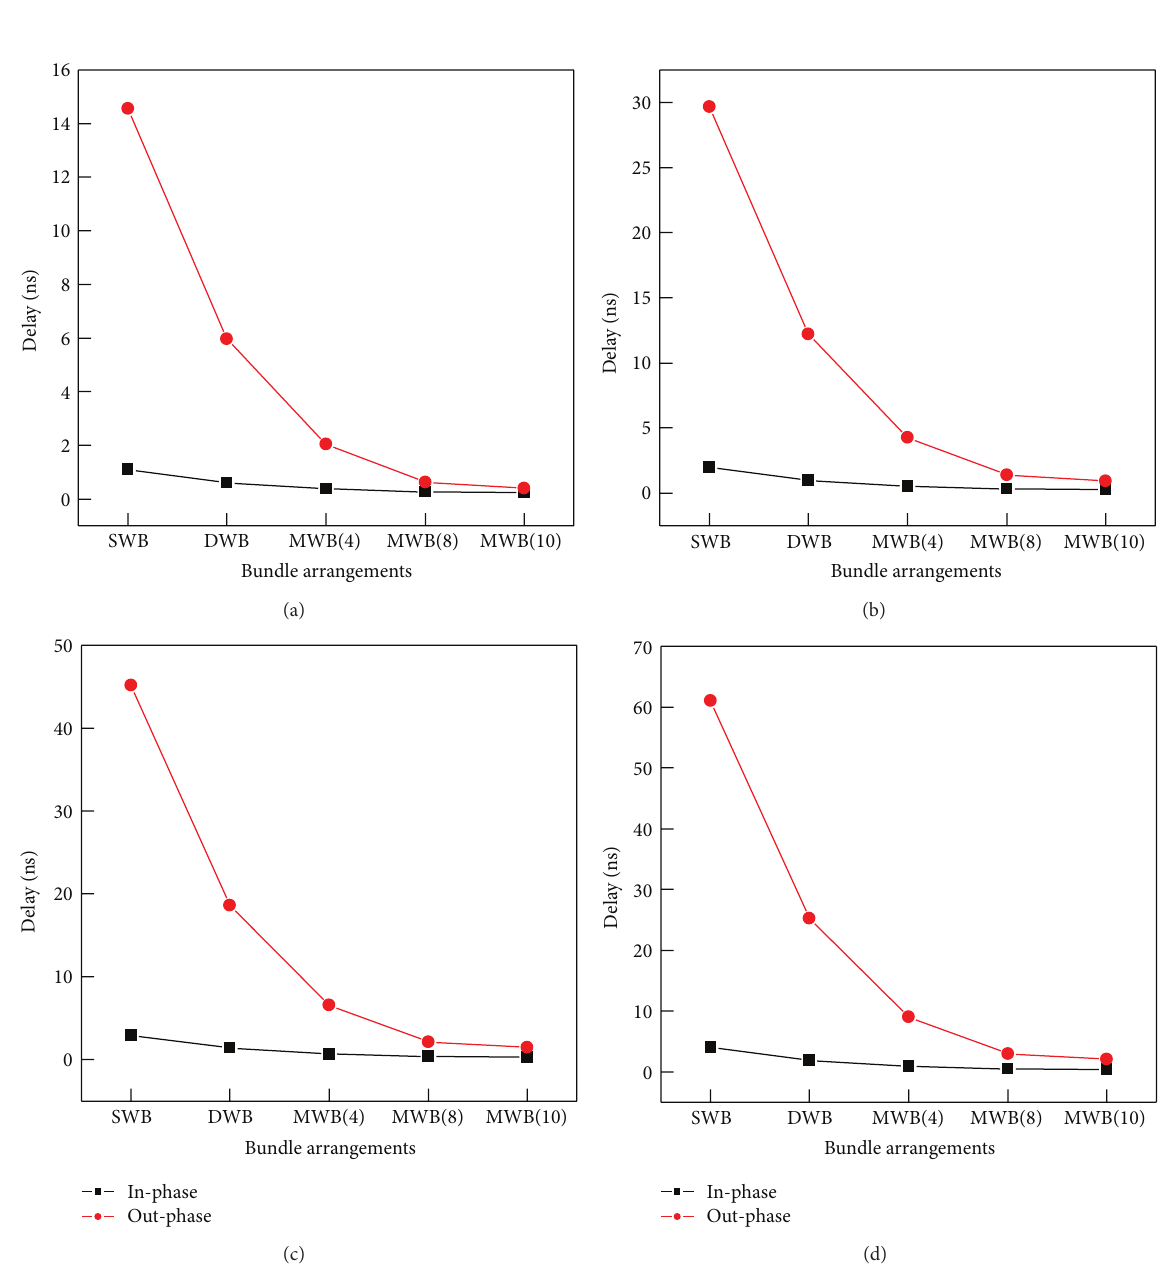
Figure 6: Crosstalk delays for different CNT bundles at (a) 50 𝜇 m, (b) 100 𝜇 m, (c) 150 𝜇 m, and (d) 200 𝜇 m TSV heights, where SWB, DWB, MWB(4), MWB(8), and MWB(10) represent the bundled SWCNT, DWCNT, and 4-shell, 8-shell, and 10-shell MWCNTs,